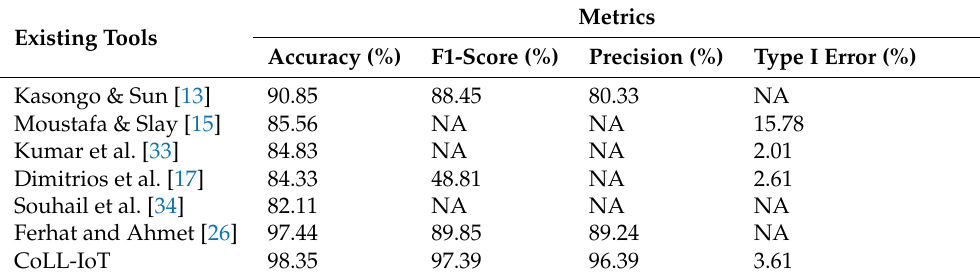
Table 7. Comparison with existing